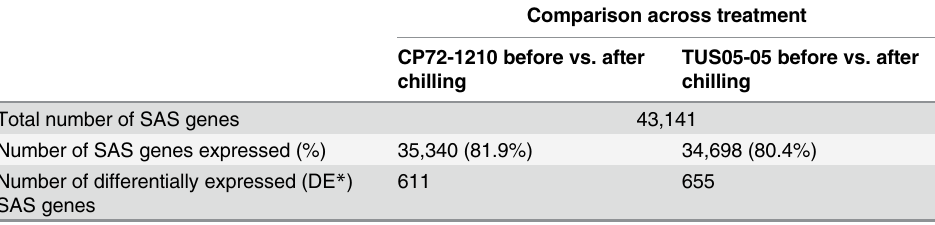
Table 2. Summary of differential gene expression analysis.